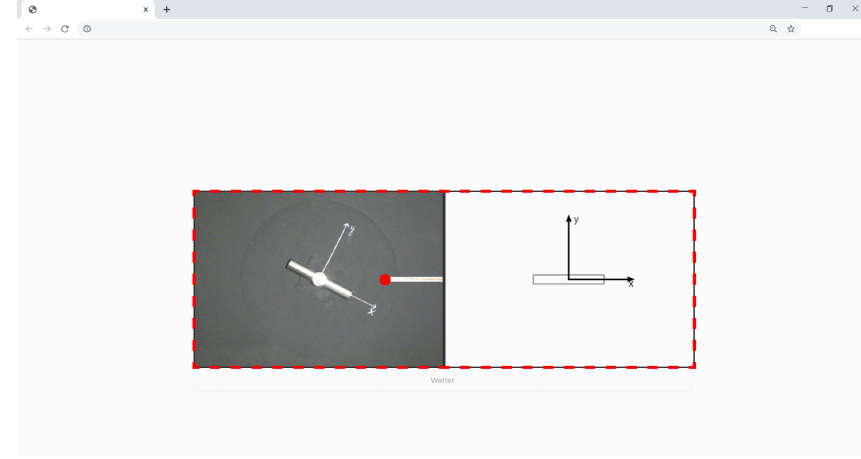
FIG. 1. View of the webpage containing the application. In the middle (within the red dashed line) the experimental setup (left) and the diagram (right) can be seen. The orientation of the laboratory system changes during data acquisition, while the orientation of the coordinate system of the diagram stays the same. The position of the sensor is marked in red. The red markings (dashed line and circle) were added here for illustrative purposes and were not included in the